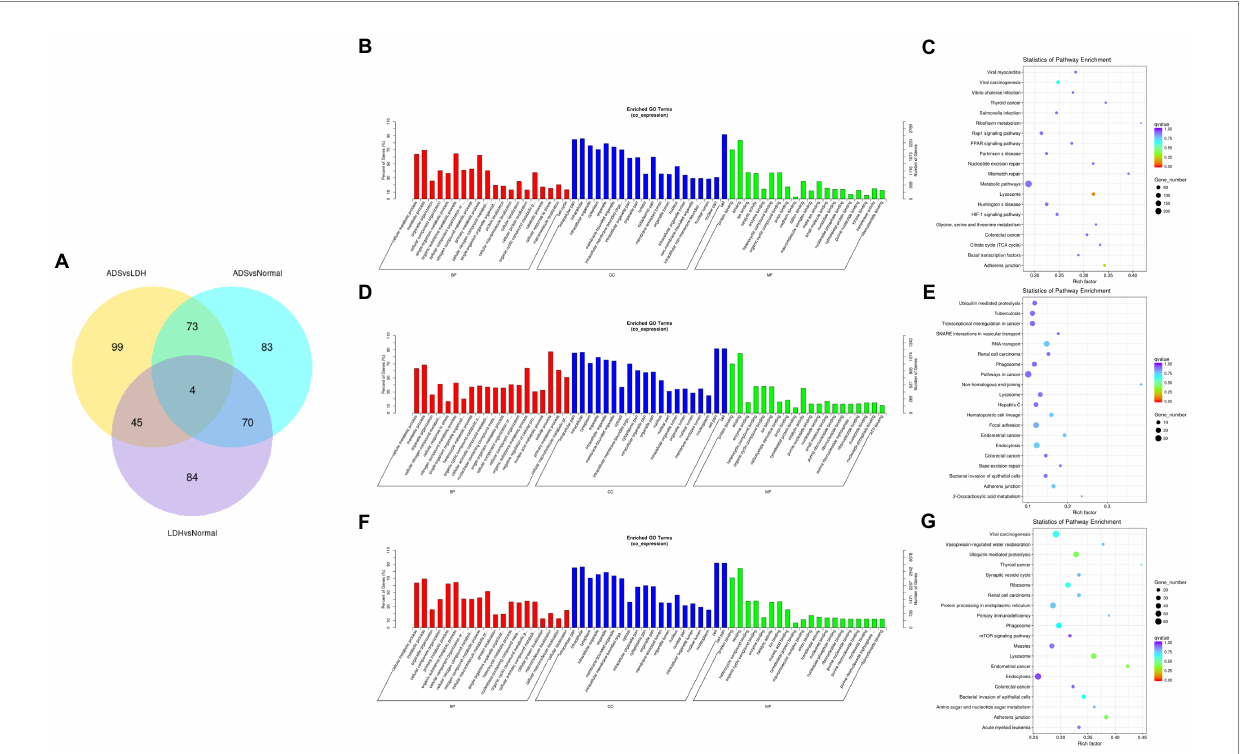
FIGURE 7 Identification of differentially expressed lncRNAs combined with the GSE209825 dataset in ADS (A) The Venn diagram created by the differentially expressed data of lncRNAs was combined with the GSE209825 dataset. (B) The 20 most enriched Gene Ontology terms for the parental genes of 73 co-significantly DE lncRNAs in the ADS compared to the LDH and Normal group. (C) The 20 most enriched KEGG pathways for 73 co-significantly DE lncRNAs. (D) The 20 most enriched Gene Ontology terms for the parental genes of 4 co-significant DE lncRNAs. (E) The 20 most enriched KEGG pathways for 4 co-significantly DE lncRNAs. (F) The 20 most enriched Gene Ontology terms for the parental genes of 99 significantly DE lncRNAs in the ADS compared to the LDH group. (G) The 20 most enriched KEGG pathways for 99 significantly DE lncRNAs. Enriched GO terms are on the vertical axis, and the number of annotated differentially expressed genes associated with each GO term is indicated on the horizontal axis. The size of the symbol represents the number of genes, and the colors represent p -value in KEGG.